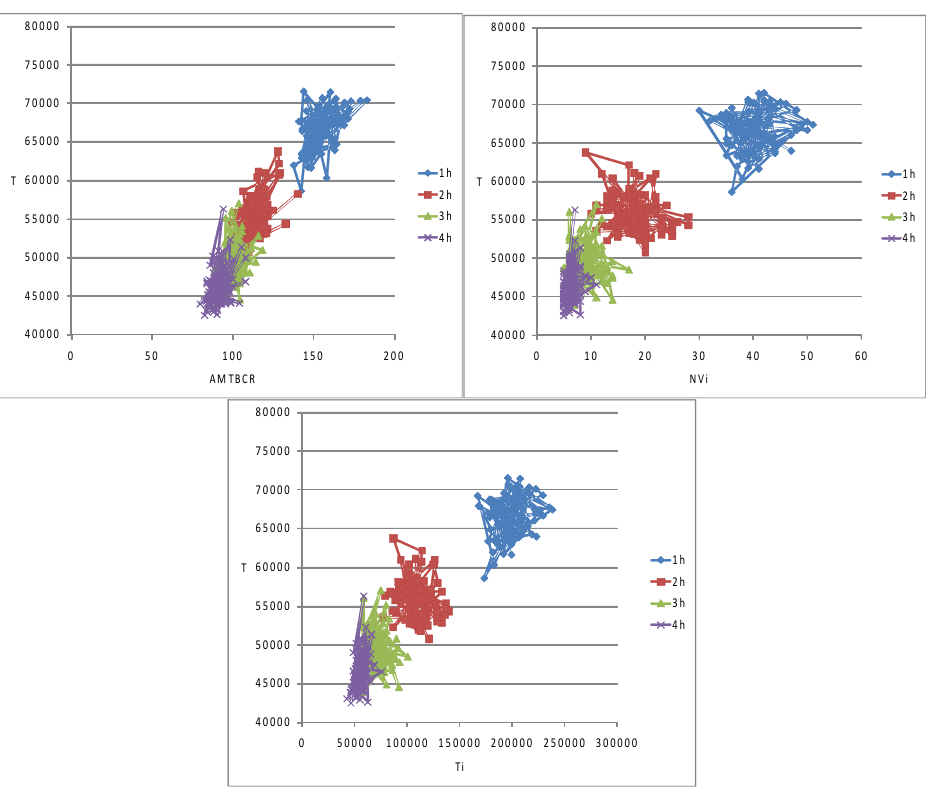
Figure 5. Travel cost (in seconds) related to AMTBCR, NV I and T I On the other hand, AMTBCR, NVI, and T I have a greater statistical dispersion and describe the same overlapping phenomena observed for T (between the cases 3h and 4h) and a separation